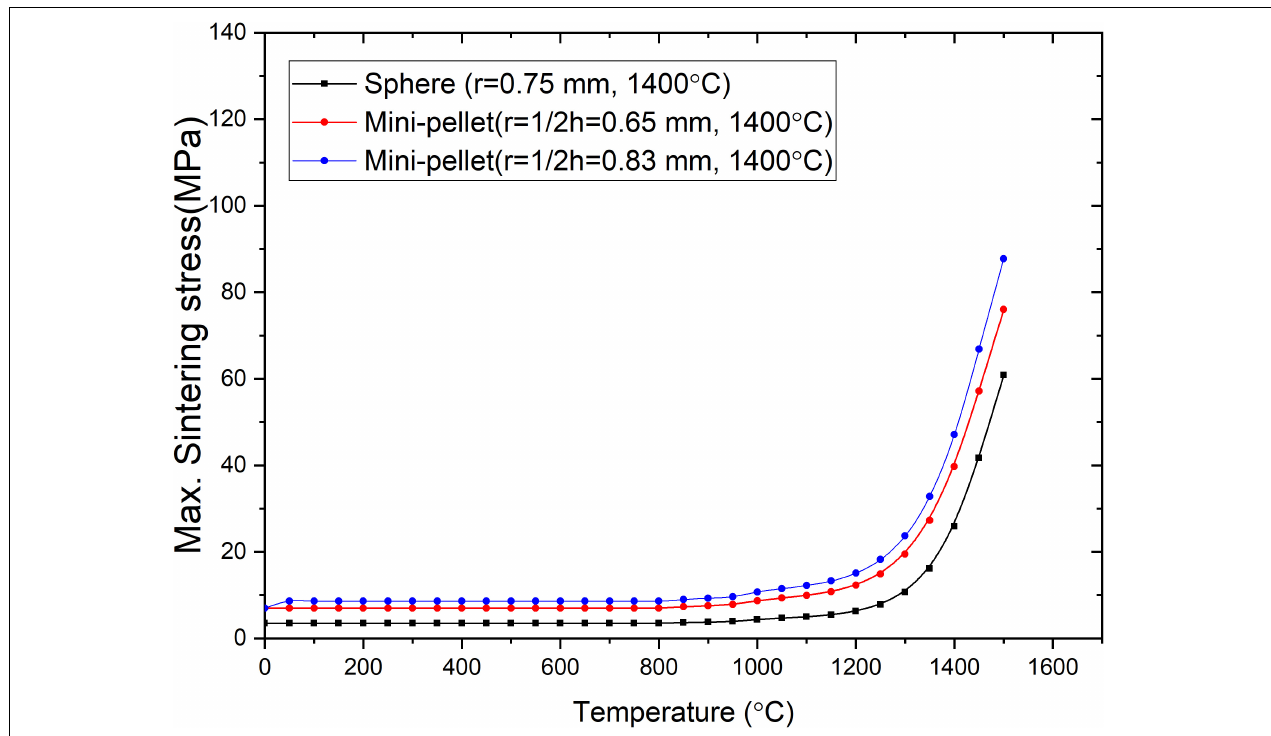
FIGURE 6 | FEA-calculated maximum sintering stress in YSZ oxide pellets containing lumped Gd 2 O 3 spheres and mini-pellets of the same volume and shrinkage rate.